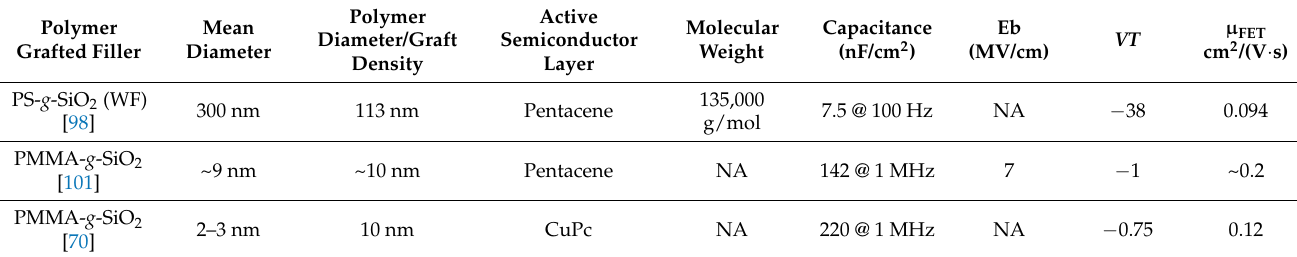
Table 3. Summary of dielectric and electronic properties of polymer brushes grafted from SiO 2 using ATRP. Polymer Grafted